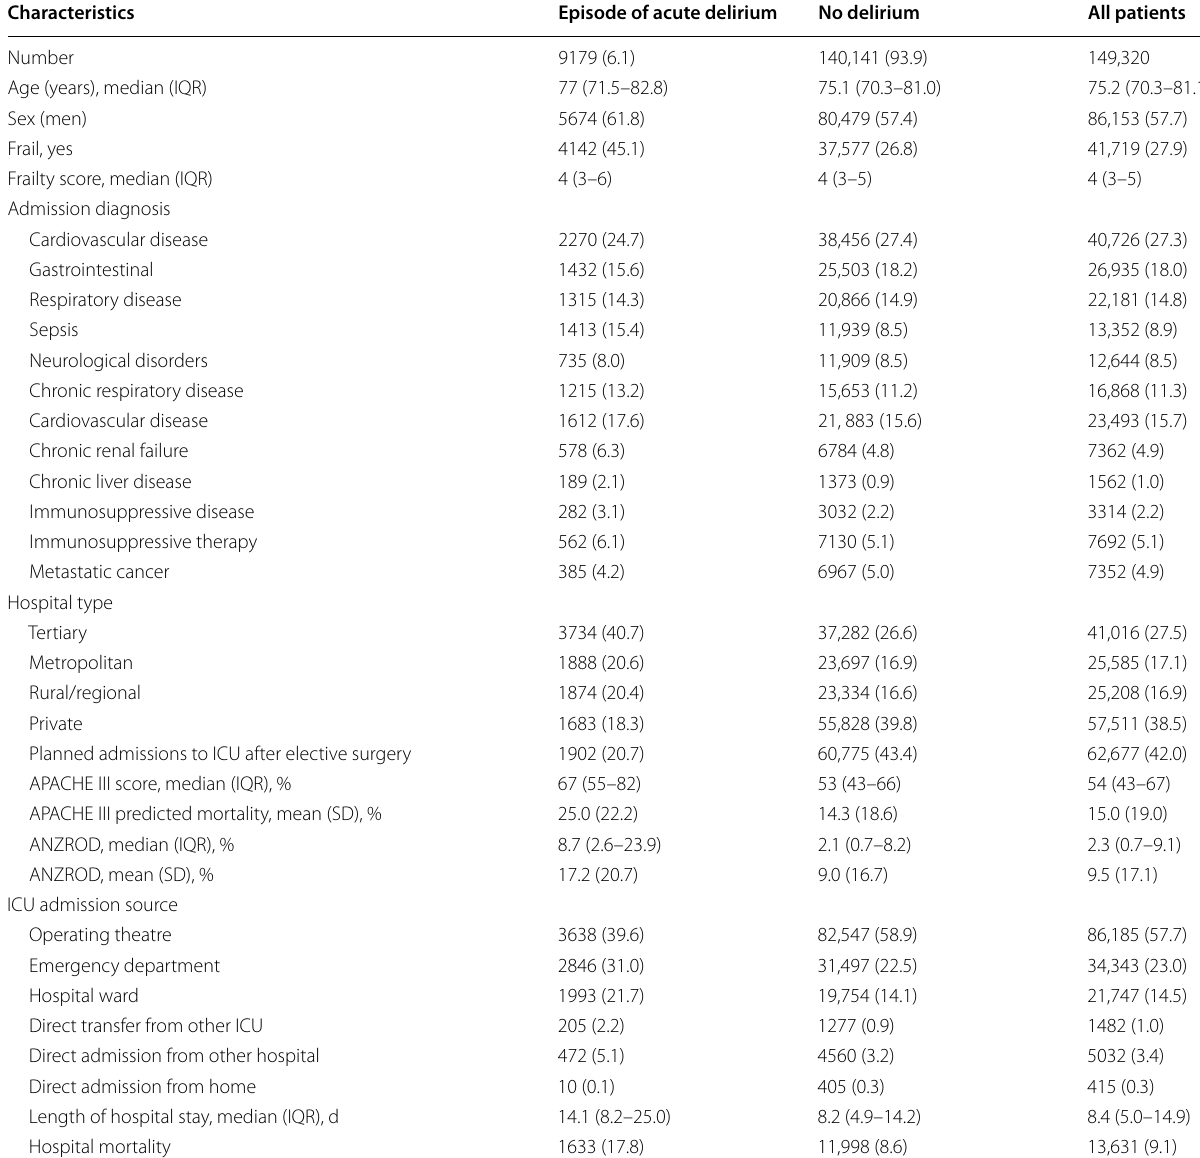
Table 1 Characteristics of the patients included in the analysis ( n